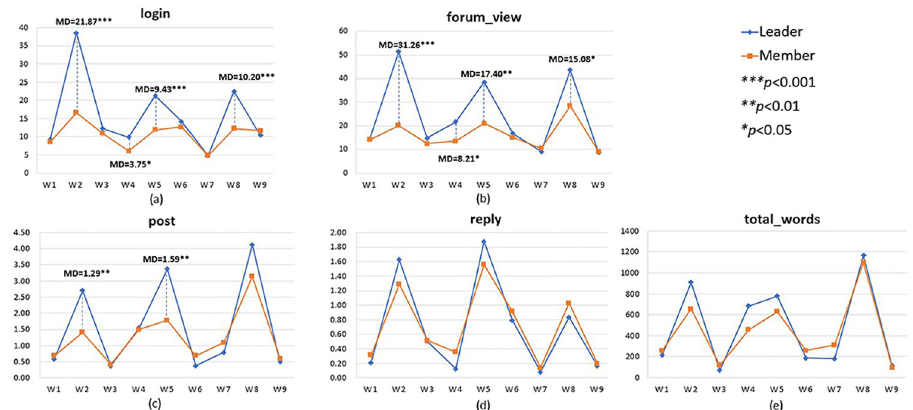
Fig 3. Participating behaviors of leaders and members.